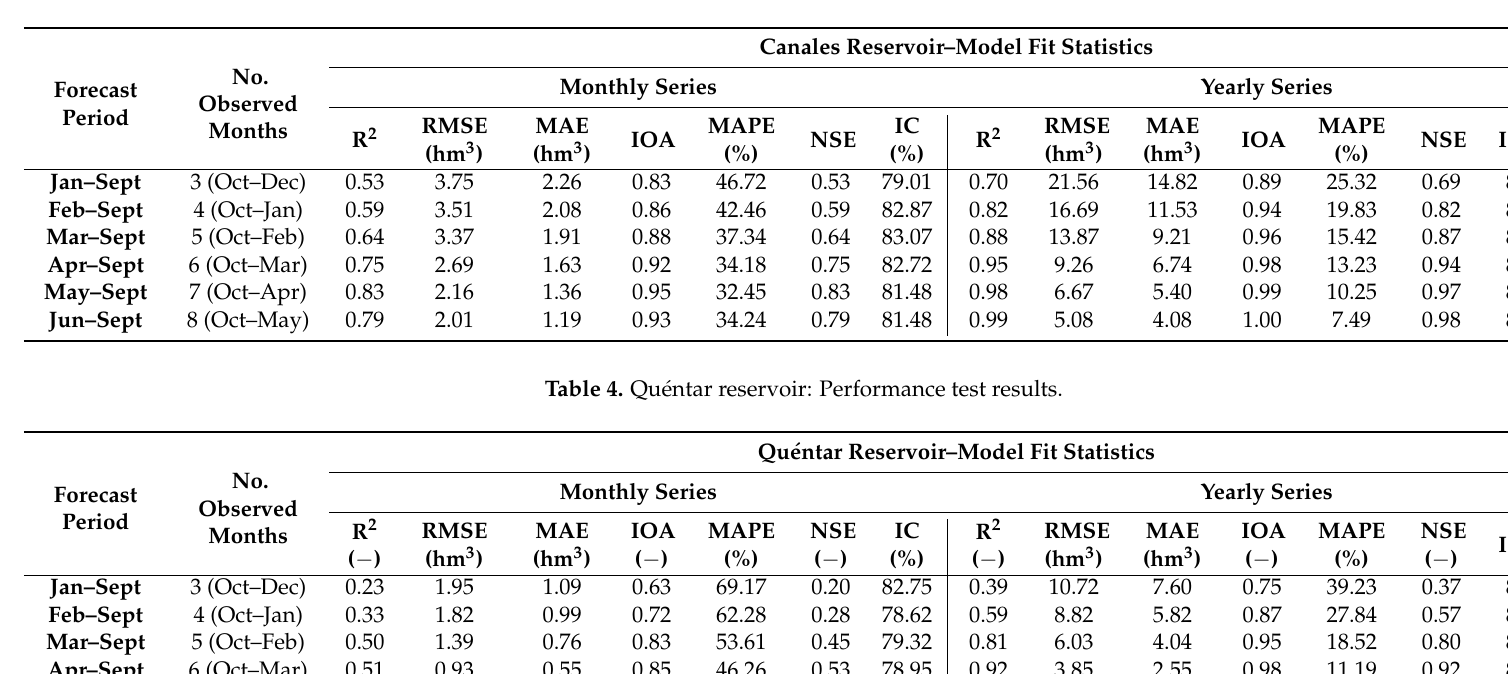
Table 3. Canales reservoir: Performance test results.